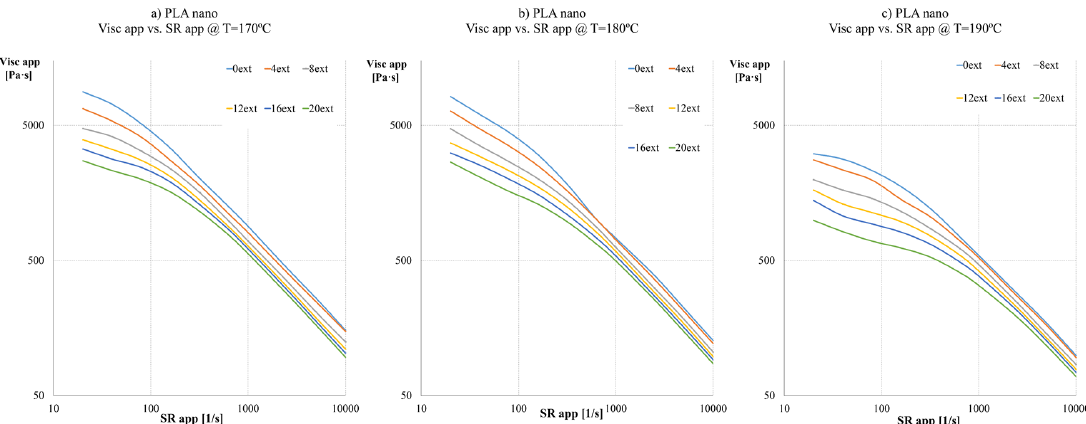
Figure 5. Apparent viscosity curves at different apparent Shear rates of each extrusion sample of: ( a ) PLA nano at 170 °C; ( b ) PLA nano at 180 °C; ( c ) PLA nano at 190 °C.